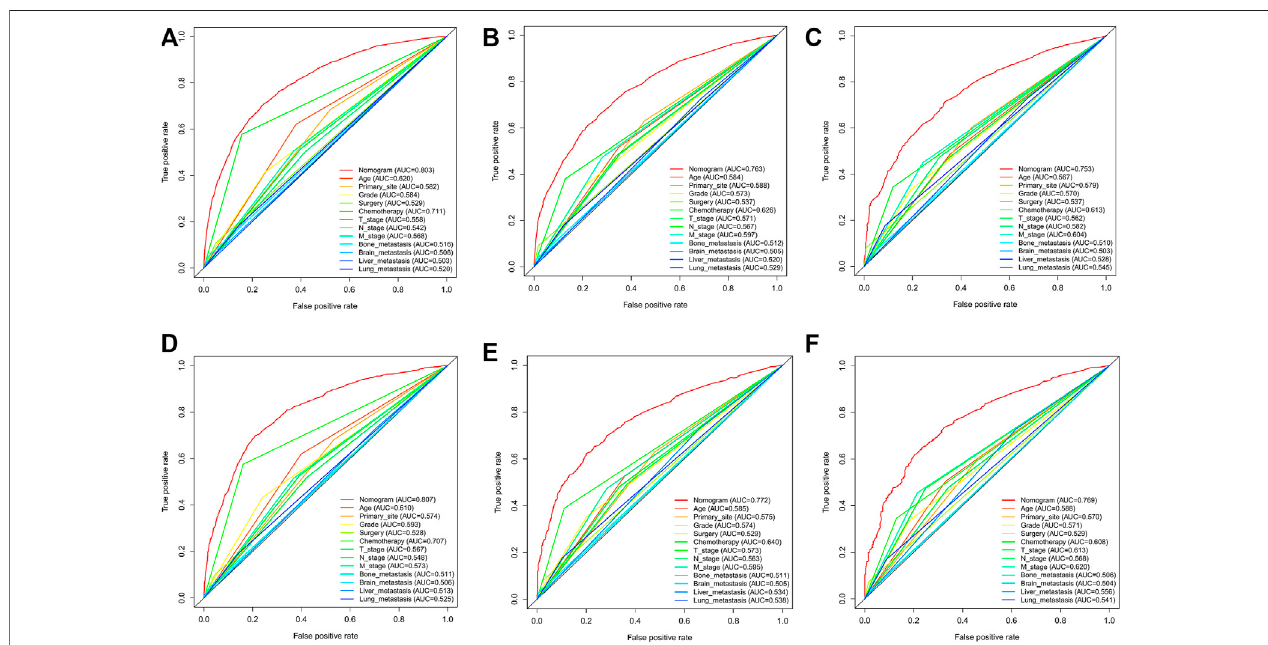
FIGURE 5 | (A – C) Nomogram ROC curves to predict 1-,3-, and 5-year overall survival; (OS) in the training cohort; (D – F) Nomogram ROC curves to predict 1-,3-, and 5-year; overall survival (OS) in the validation cohort.